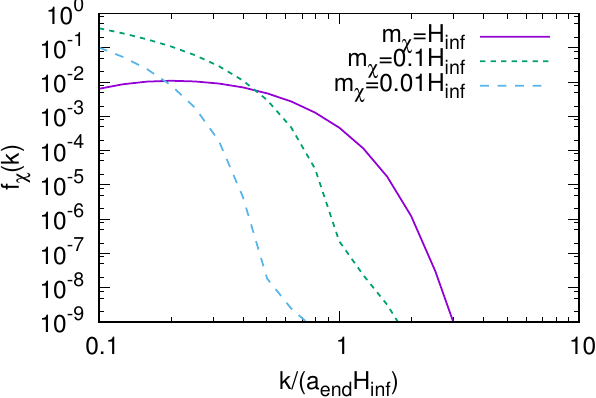
The phase space distribution of (cid:31) after the gravitational particle production in a toy model (A.1) with conformal coupling (cid:24) = 1 = 6, for m (cid:31) = (1 ; 0 : 1 ; 0 : 01) (cid:2) H inf . Open